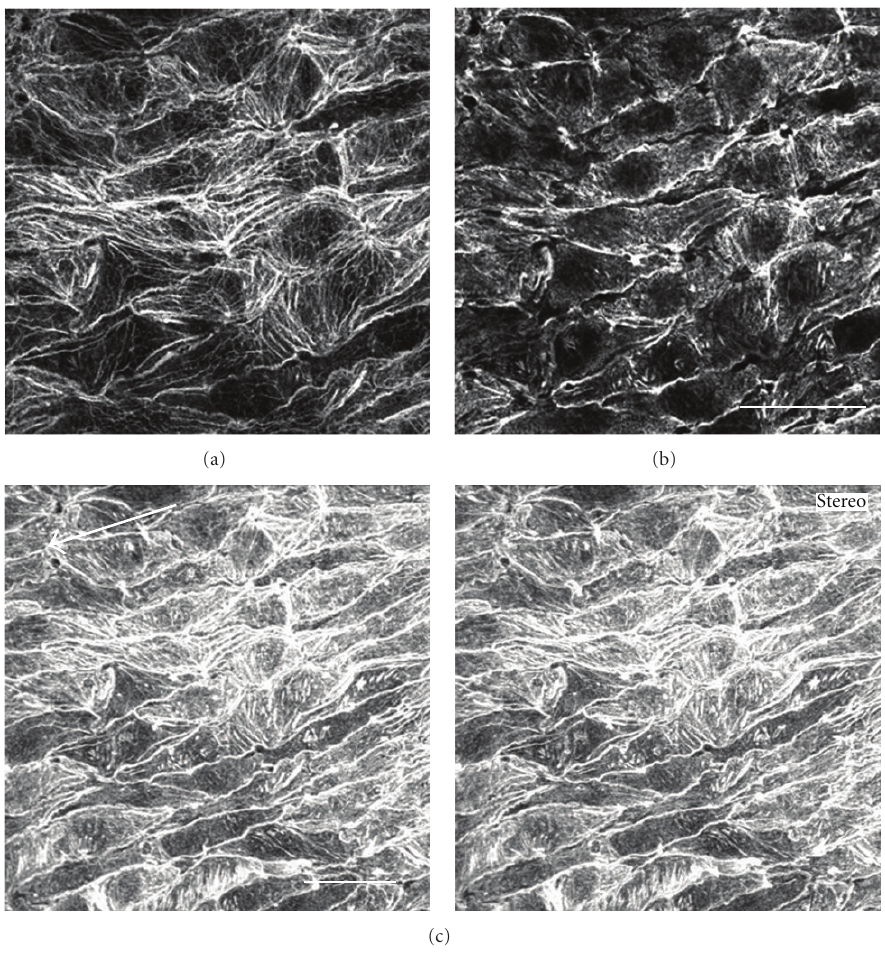
Figure 2: Endothelial cells in the renal artery stained with rhodamine-labeled phalloidin. The focal plane was adjusted to the surface (a) or basal (b) portion of the endothelial cells. The three-dimensional distribution of actin filaments reconstructed using 20 serial confocal optical sections from (a) to (b) is shown in (c) (stereo pair image). Thick stress fibers were observed in the basal portion of the cells oriented perpendicular to the direction of blood flow (b: see also stereo pair image). In contrast, both parallel and perpendicular stress fibers oriented along the direction of flow were seen in the apical portion of the cells (a: see also stereo pair image). To see stereo image (c), use special glasses or a light source split into the viewer’s eyes. The focal plane closer to the viewer in stereo image (c) is the apical surface of the renal endothelial cells. The arrow indicates the direction of blood flow. Bars in (b) and (c): 100 µ